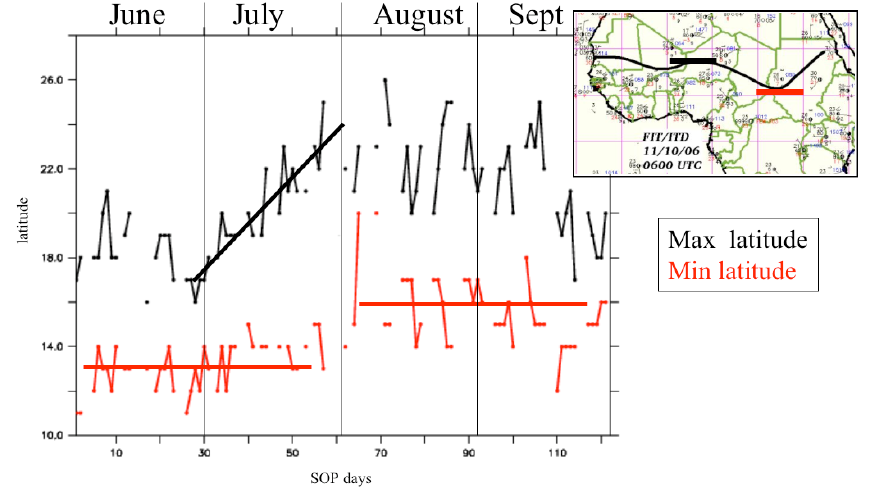
Figure 11. Based on the daily monitoring of the ITD latitude at ACMAD in June-September 2006 (see the inset plot for one-day example and full reference at http://www.acmad.ne/en/prevision/quotidien/pmfit.htm). The black lines are for the northernmost latitude over the longitudes 15°W-30°E and the red lines the southernmost latitude. The x-axis labels are expressed in days from June 1 st . of 1006 hPa. After this the heat low filled-in and retreated southeastward until the end of the monsoon season, except for a temporary westward excursion at the end of